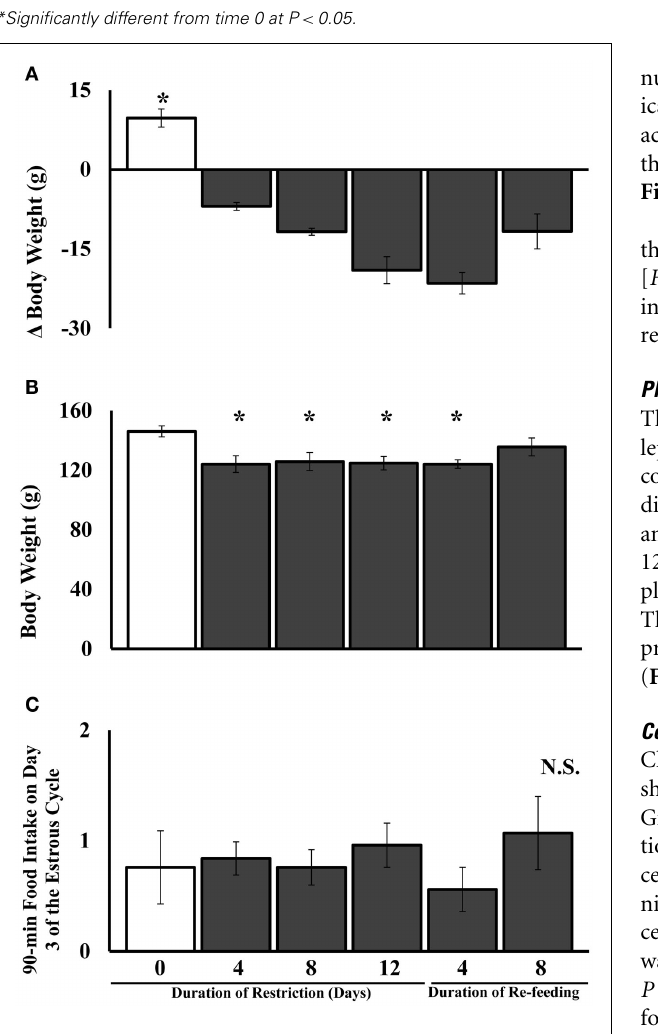
FIGURE 2 | Mean and SE of the mean for (A) . body weight change, (B) final body weight, and (C) 90-min food intake of female Syrian hamsters either fed ad libitum or food-restricted to 75% of their ad libitum intake for 4, 8, or 12days or food-restricted for 12days and then re-fed for 4 or 8days in Experiment 1. *Significantly different from ad libitum at P <